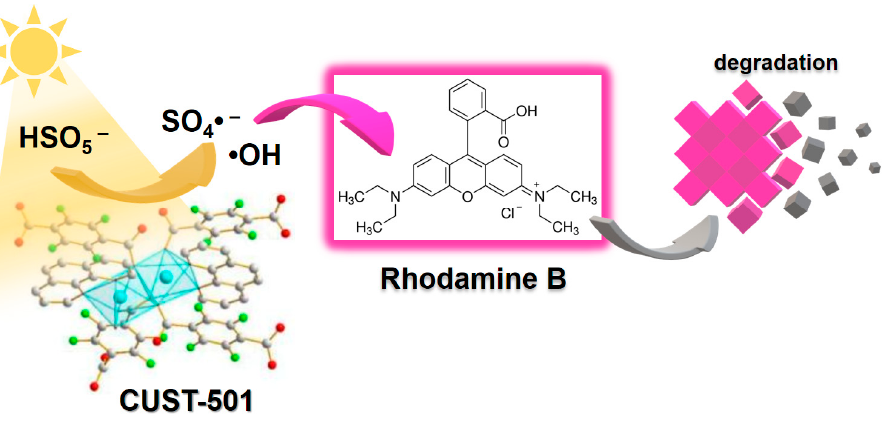
Figure 3. Schematic view of rhodamine B photodegradation mechanism with the use of CUST-501. The effective photodegradation of methylene blue and methyl violet under UV irra-